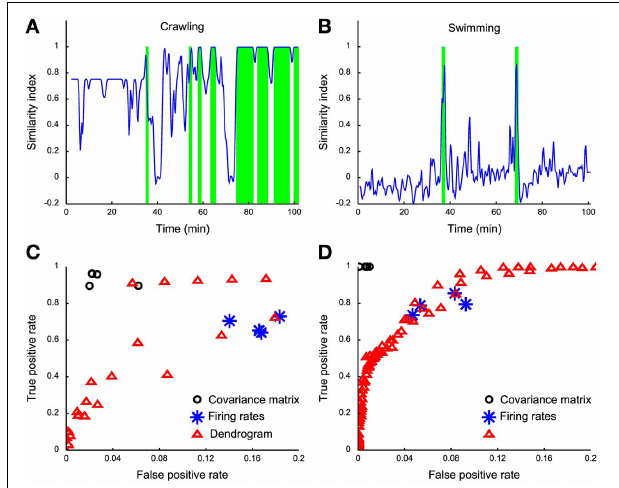
FIGURE 8 | Behavior detection using dendrograms. (A) Time course of the similarity index of dendrograms estimated in a sliding window (1s wide) using the crawling template dendrogram. (B) Time course of the similarity index of dendrograms estimated in a sliding window of 1s using the swimming template dendrogram. (C) ROC analysis on different crawling classifiers: black dots represent covariance matrix classifiers (linear, diaglinear, quadratic, and diagquadratic, see Methods), blue asterisks represent firing rate classifiers (linear, diaglinear, quadratic, and diagquadratic, see Methods) and red triangles represent dendrogram classifiers based on mutual information similarity index with varying threshold k (see Methods). (D) Same as (C) , but for swimming.